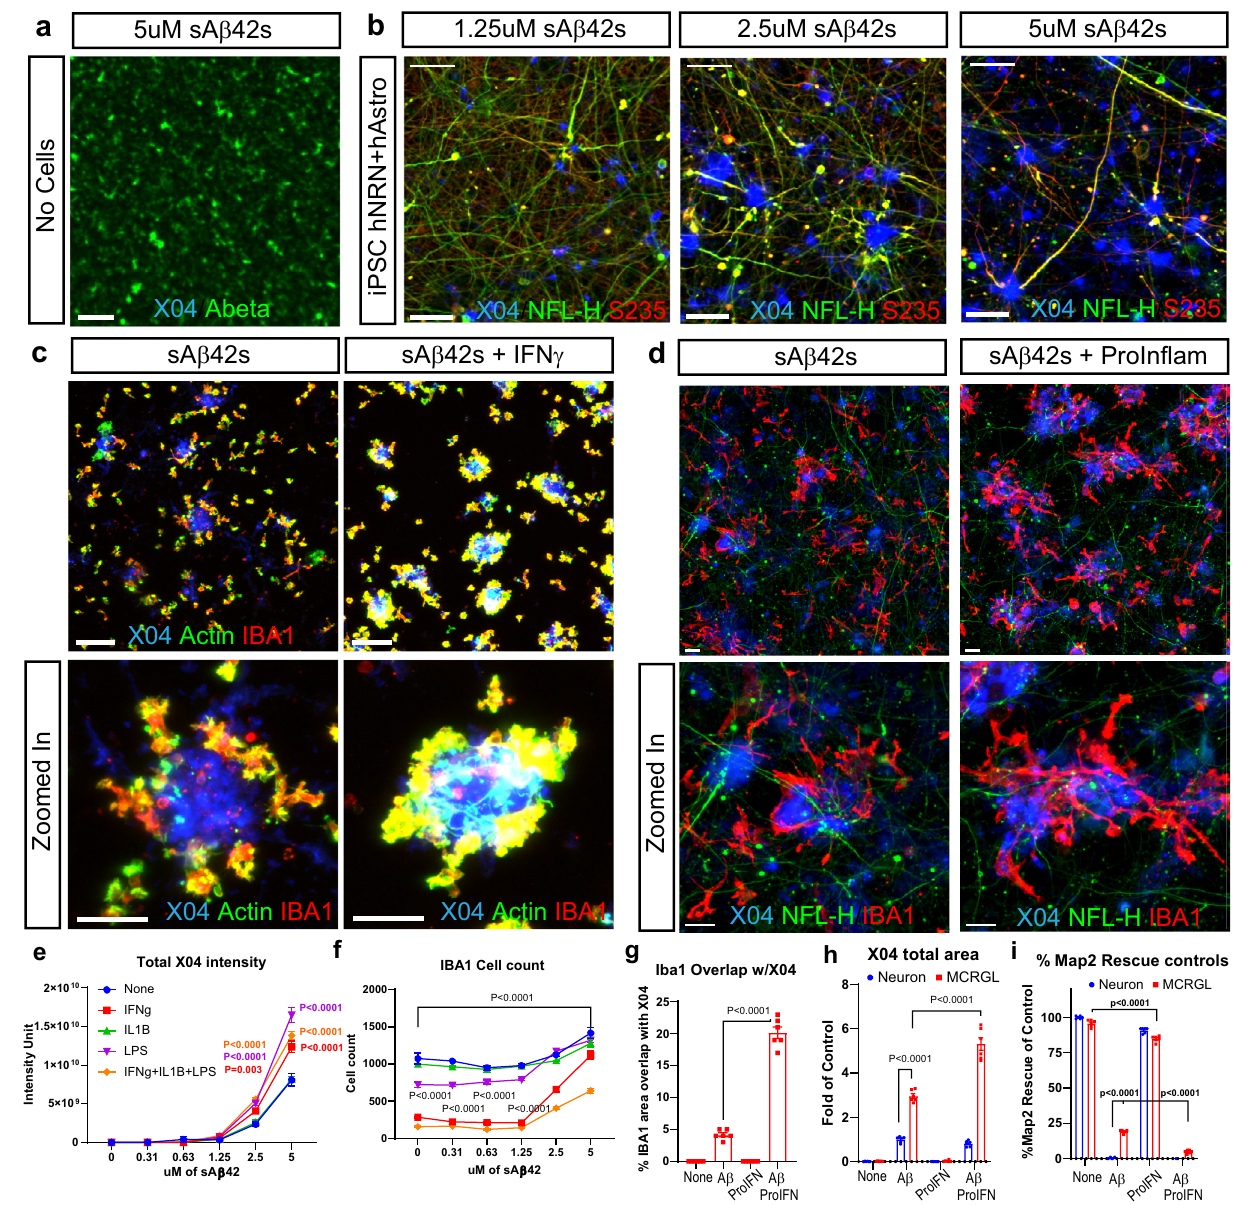
Fig. 4 Microglia activation increases A β plaque formation but reduces neuroprotection. a sA β 42s were added to empty wells (scale bar = 20 μ m) or b 12-week-old iPSC neurons at the indicated concentrations. All wells were stained with X04 (blue), A β (green), NFL-H (green), and p-Tau S235 (red). Empty wells have A β precipitates but no XO4 positive structure. In iPSC neuron wells, there is a dose-dependent increase of X04 staining. A Subset of XO4 is also surrounded by dystrophic neurites (NFL-H and S235 positive axonal swellings). Scale bar = 50 μ m. c Microglia treated with sA β 42s ranging from 0 to 5 μ M and also treated in combination with IFN γ . The panel below shows a zoomed-in section. A β plaques are stained with X04 (blue), microglia are labeled with Actin (green), and IBA1 (red). Scale bar = 50 μ m. IFN γ increases plaque formation and plaque interaction. e Quanti fi cation of X04 intensity . f Quanti fi cation of IBA1 number. d Neuron and astrocytes coculture and triculture of neurons, astrocytes, and microglia were treated with sA β 42s with or without pro-in fl ammatory cytokine combination (IFNy + IL1b + LPS). Representative images from indicated conditions are shown. The lower panel of zoomed images is shown. A β plaque was stained with X04 (blue), dystrophic neurites swellings were stained with NFL-H (green), and microglia were labeled with IBA1 (red). In triple culture, sA β 42s addition led to A β plaque formations surrounded by dystrophic neurites and encircled by microglia similar to plaque presentation in vivo. Scale bar = 20 μ m. g The area of IBA1 overlap with X04 is quanti fi ed. Pro-in fl ammatory cytokines increased microglia association with plaque. h Microglia increased the X04 plaque area, as measured by the total area of X04 staining. Pro-in fl ammatory cytokine addition increased the plaque area furthermore. MAP2 areas were also quanti fi ed in ( i ). sA β 42s addition caused a severe reduction to neuron culture. Microglia culture provided 25% MAP2 protection from sA β 42s. This protection is lost when pro-in fl ammatory cytokine is added. Data are presented as mean values + / − SEM and n = 4 wells. Two-way ANOVA with ( e , f , h , i ) Tukey ’ s or ( g ) Dunnett ’ s multiple comparisons